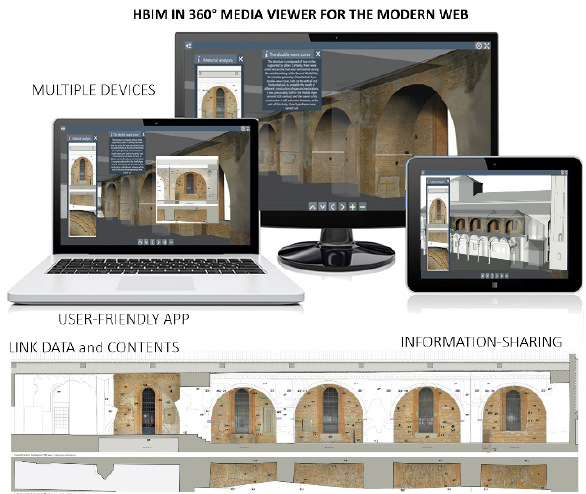
Figure 12. Information sharing among experts thanks to different type of visualizations and